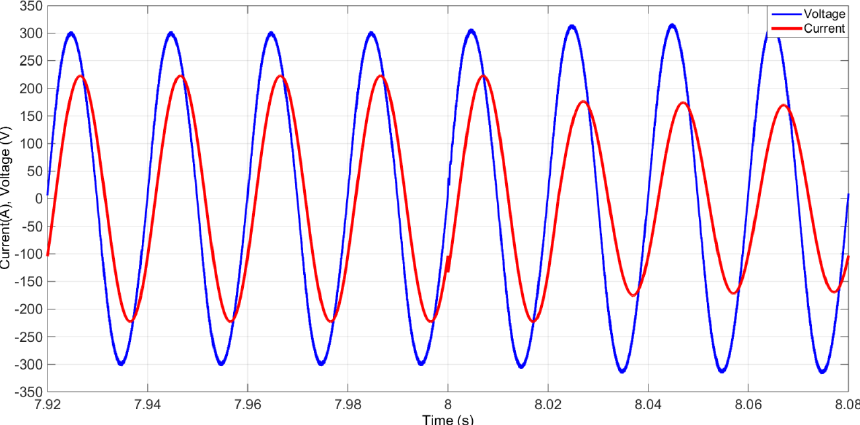
Figure 12. The waveform of the terminal voltage of load model and load current.